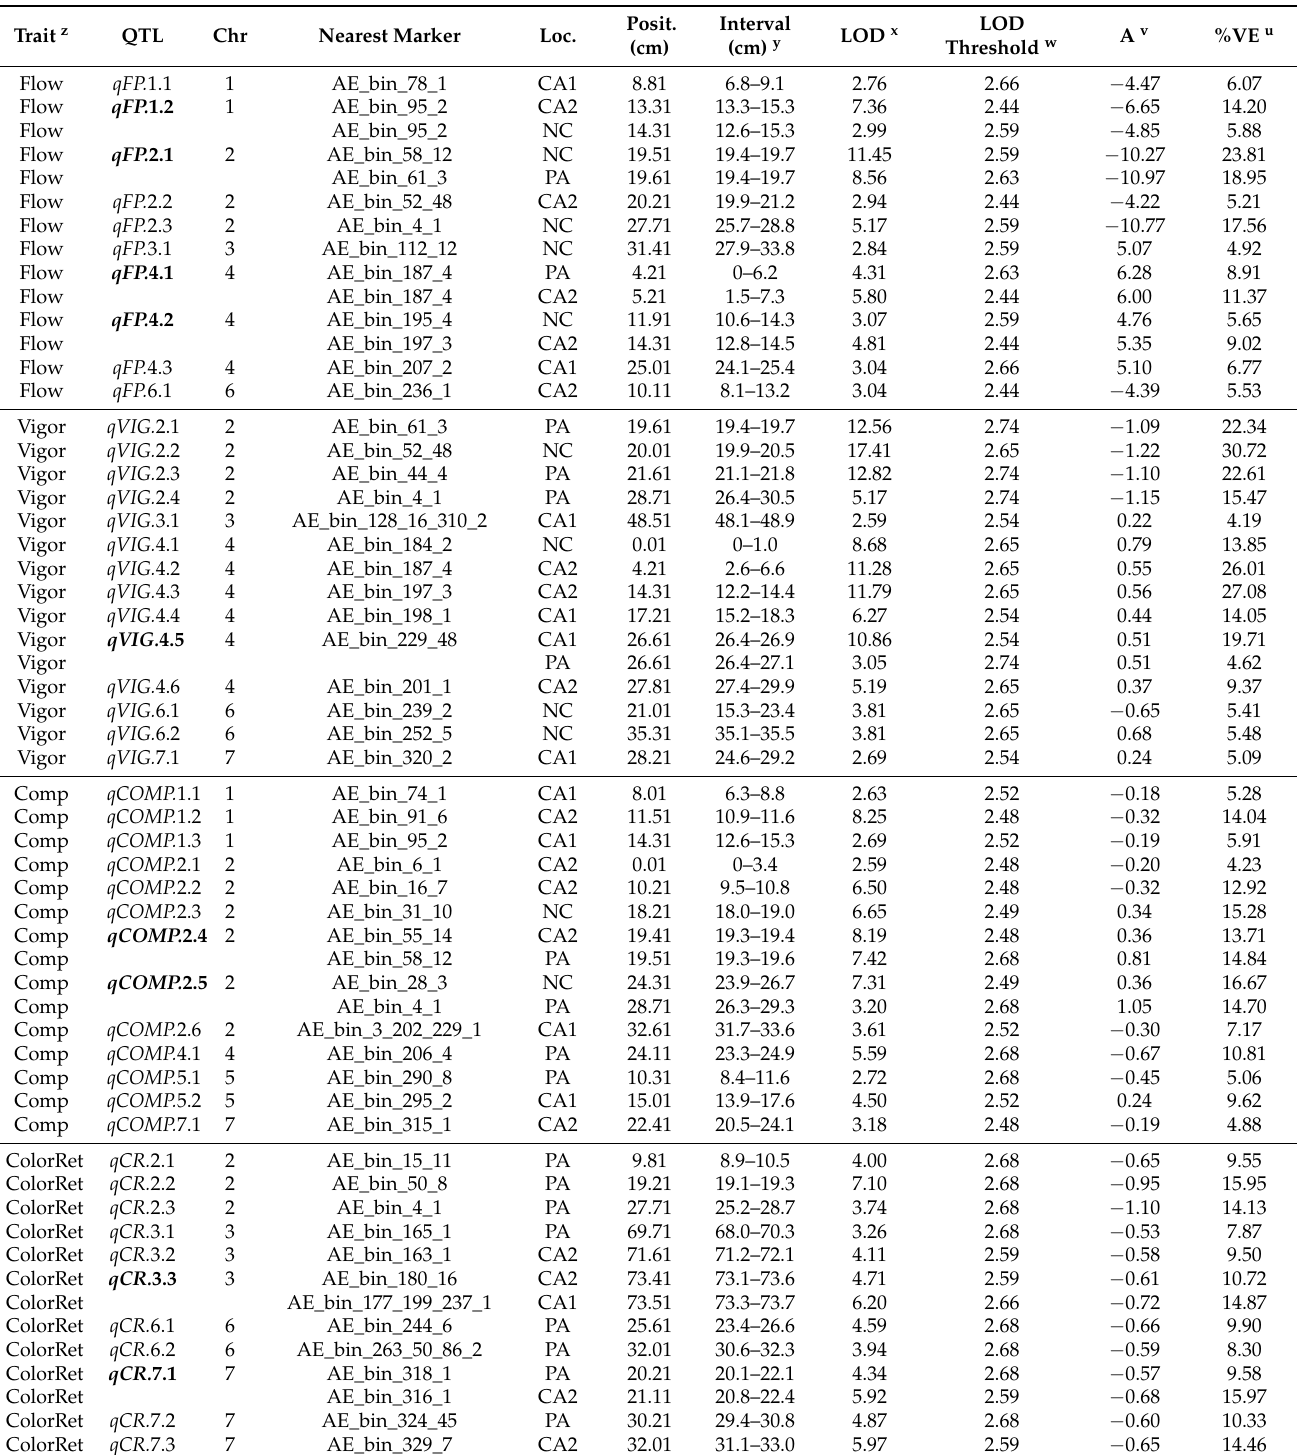
Table 5. Summary of QTL identified at four field locations for the P. axillaris × P. exserta F 7 recombinant inbred line population. QTL identified at multiple locations with overlapping confidence intervals were considered robust QTL (rQTL) and are highlighted in